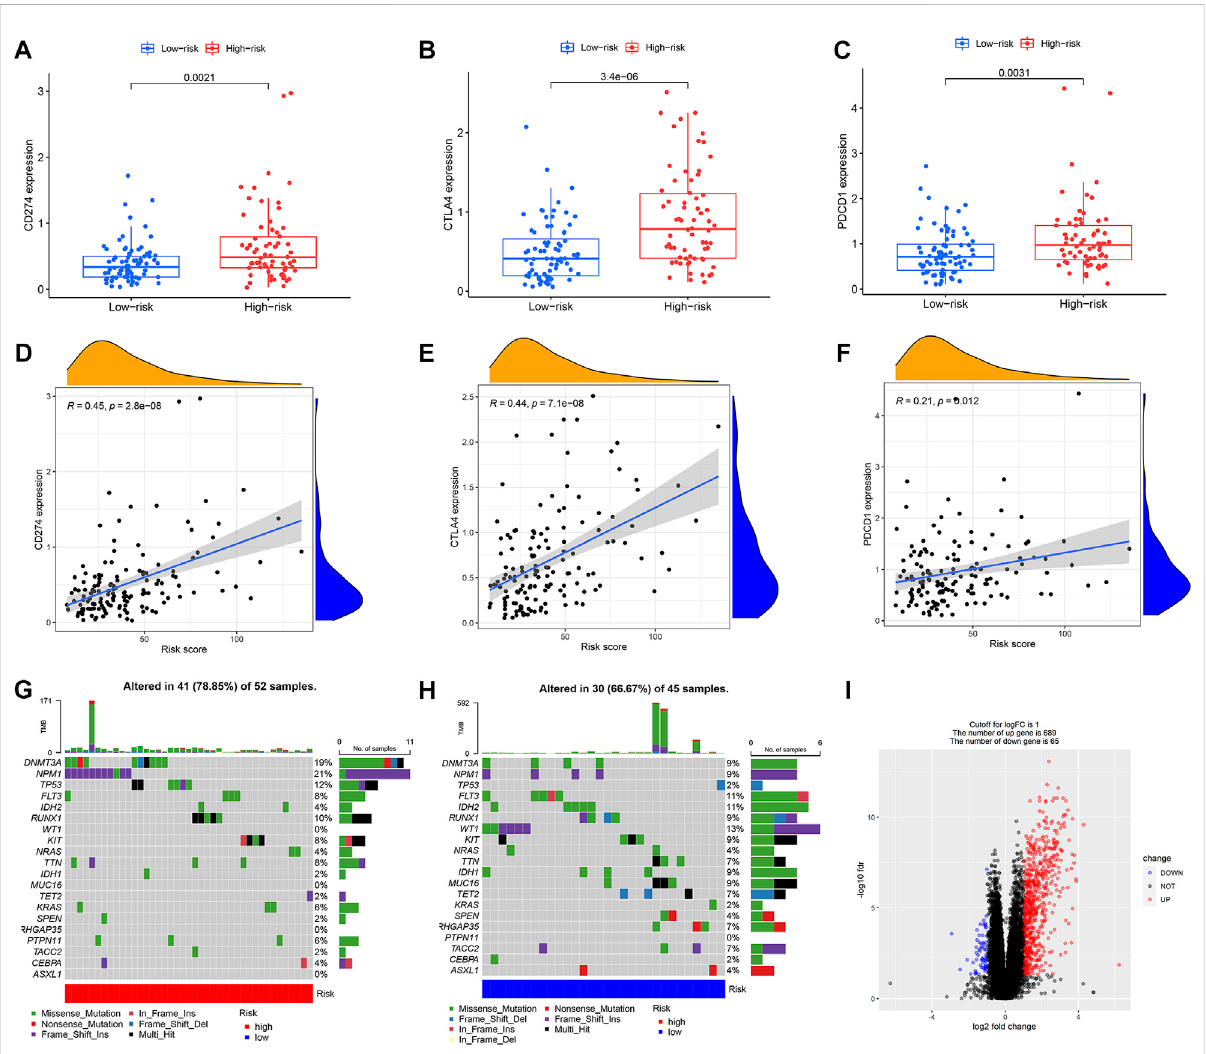
FIGURE 5 Characteristics of mutations and immune checkpoints between high and low risk groups. (A) Expression of CD274 between high and low risk groups. (B) Expression of CTLA4 between high and low risk groups. (C) Expression of PDCD1 between high and low risk groups. (D) Correlation betweenCD274andriskscore. (E) CorrelationbetweenCTLA4andriskscore. (F) CorrelationbetweenPDCD1andriskscore. (G) Tumormutationsin the high-risk group. (H) Tumor mutations in the low-risk group. (I) Volcano map of differential gene